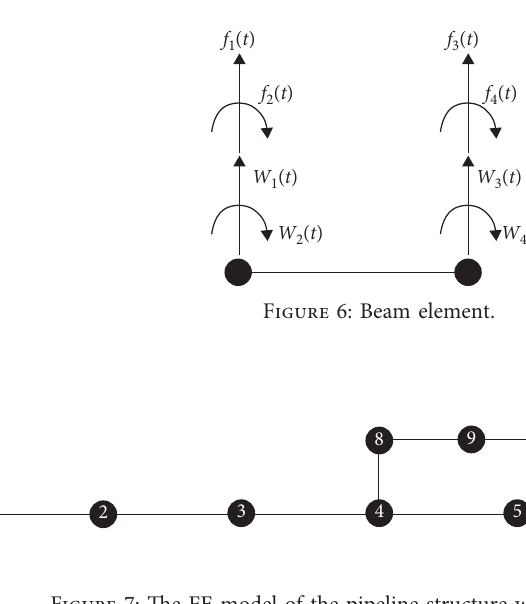
S , according to equation (1) [8].